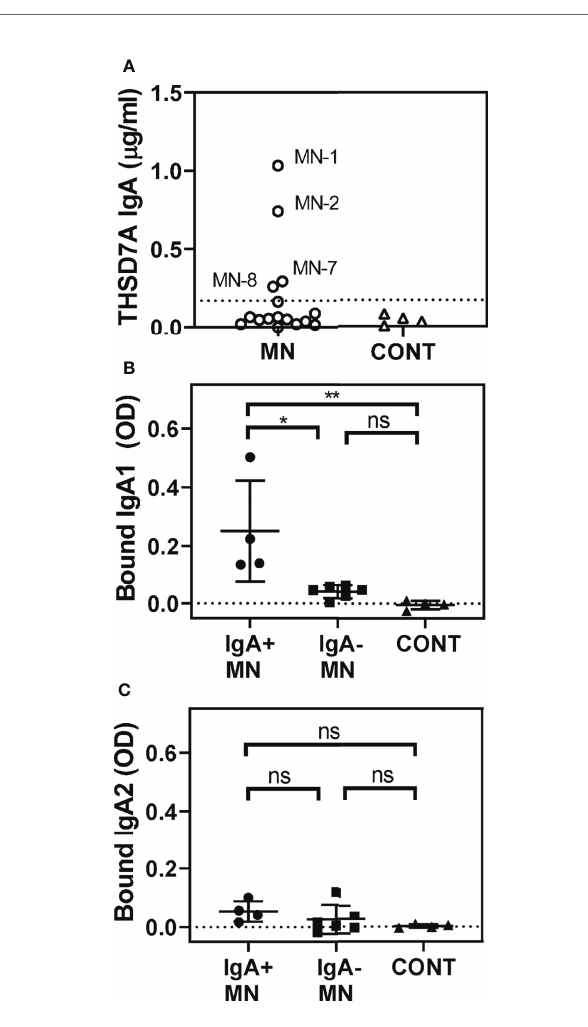
FIGURE 2 | Identi fi cation of IgA anti-THSD7A autoAbs. (A) Quantitative analysis of anti-THSD7A IgA in MN sera (circles). The threshold for positivity, depicted by the dotted line, was de fi ned as the mean + 4SD of control sera (tringles). B-C. IgA-positive MN sera (circles) show signi fi cantly higher binding to THSD7A of IgA1 (B) but not IgA2 (C) , compared to IgA-negative MN sera (squares) or control sera (triangles). The signi fi cance of differences among groups was analyzed by one-way ANOVA follow by Bonferroni ’ s test for multiple comparison (ns, not signi fi cant; *p<0.05; **p<0.01).